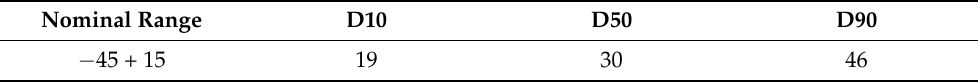
Table 1. SS316L particle size ( µ m).